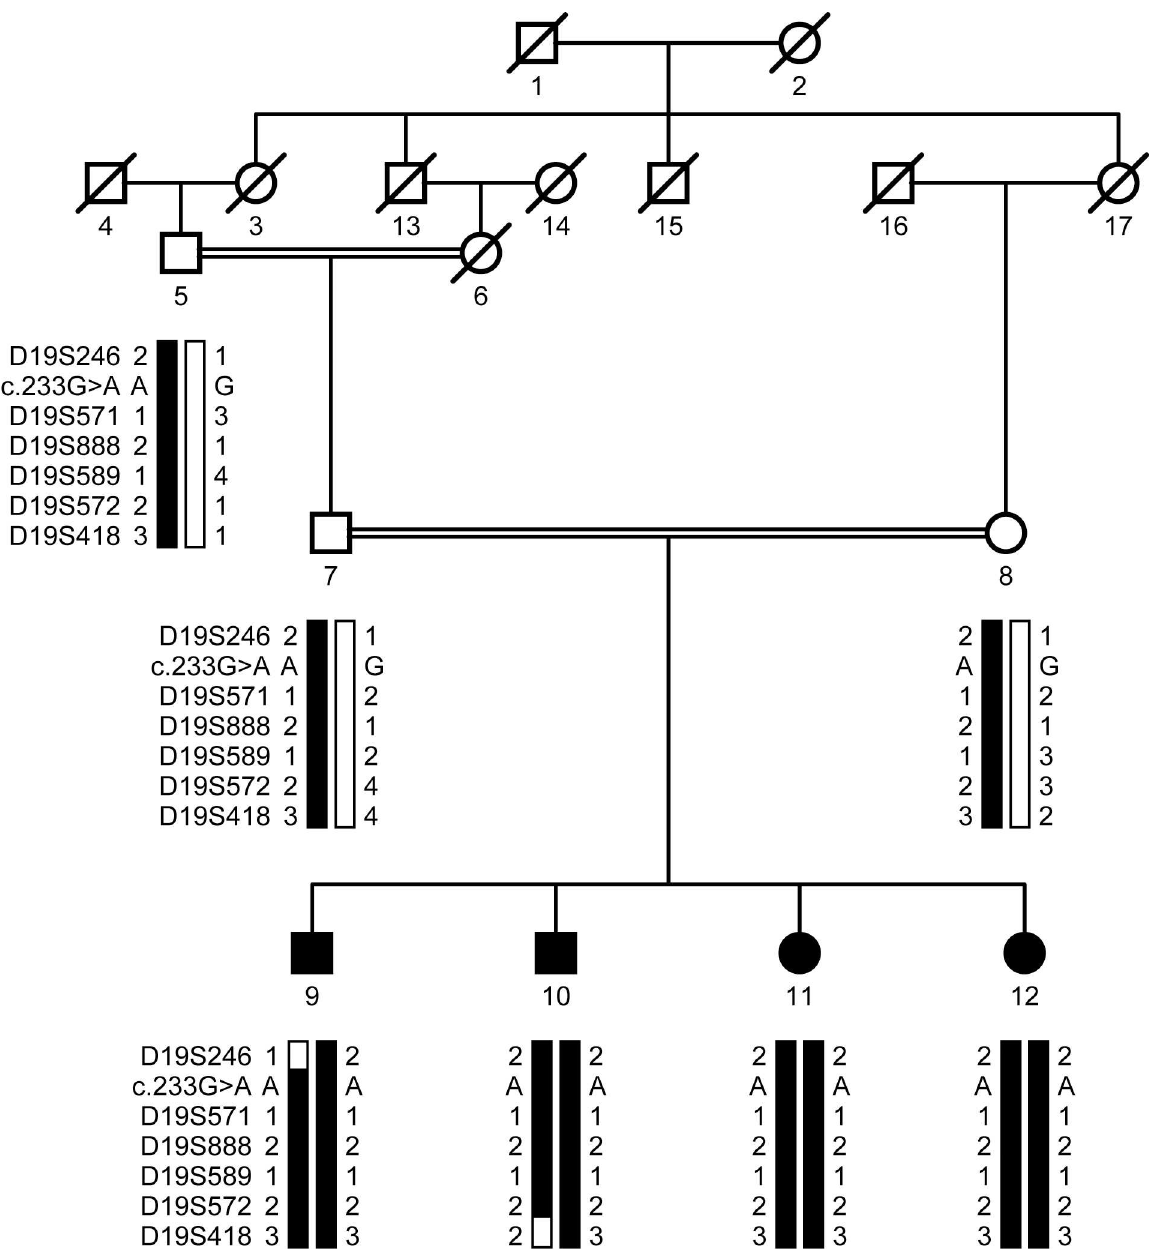
Fig 1. Pedigree drawing of the family PKCC214 with haplotypes of 6 adjacent chromosome 19q microsatellite markers. Allelesthat constitute the risk haplotypeare shaded black and alleles not co-segregating with cataracts are shown in white. Square: male; circle: female; filled symbol: affected individual; doubleline between symbols: consanguineous mating; diagonalline through symbol: